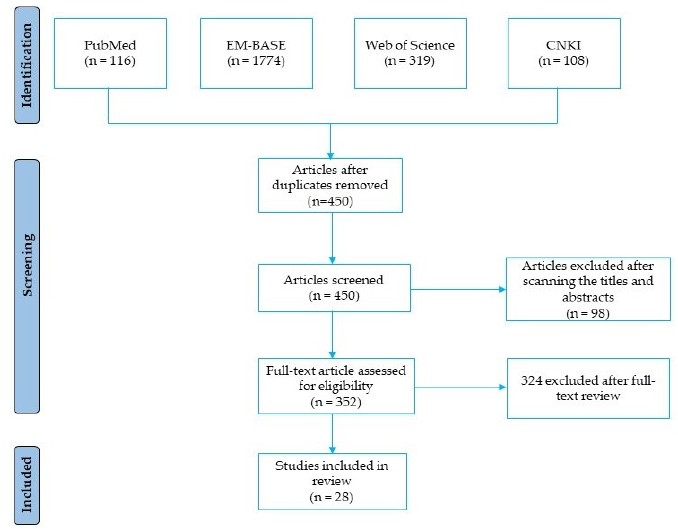
Figure 3. The flowchart of study selection for this systematic review.